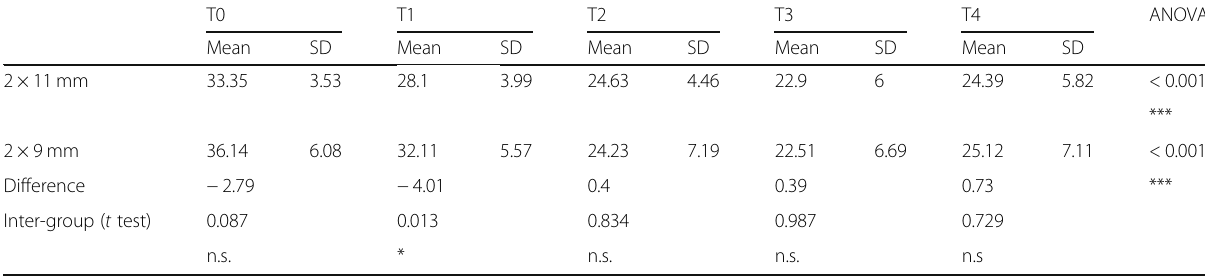
Table 2 Mean ISQ values: inter-group comparison (columns) and intra-group changes over time (rows) T0 T1